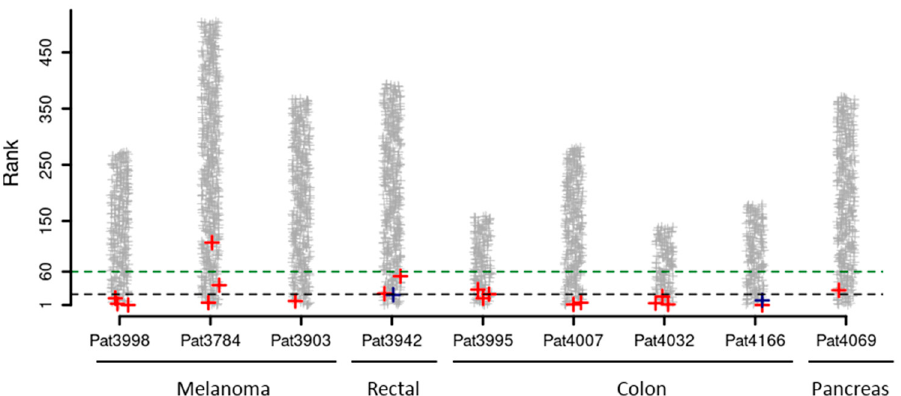
Figure 2. VENUS ranking of experimentally validated neoantigens: Ranking of 20 experimentally validated neoantigens according to VENUS RSUM score. Better ranks correspond to lower values on the y-axis. Grey crosses represent all neo-peptides generated by somatic mutations in each patient. Experimentally validated CD8+ and CD4+ reactivities are depicted in red and blue, respectively. Horizontal lines indicate thresholds for the top 20 (black) and top 60 (green)